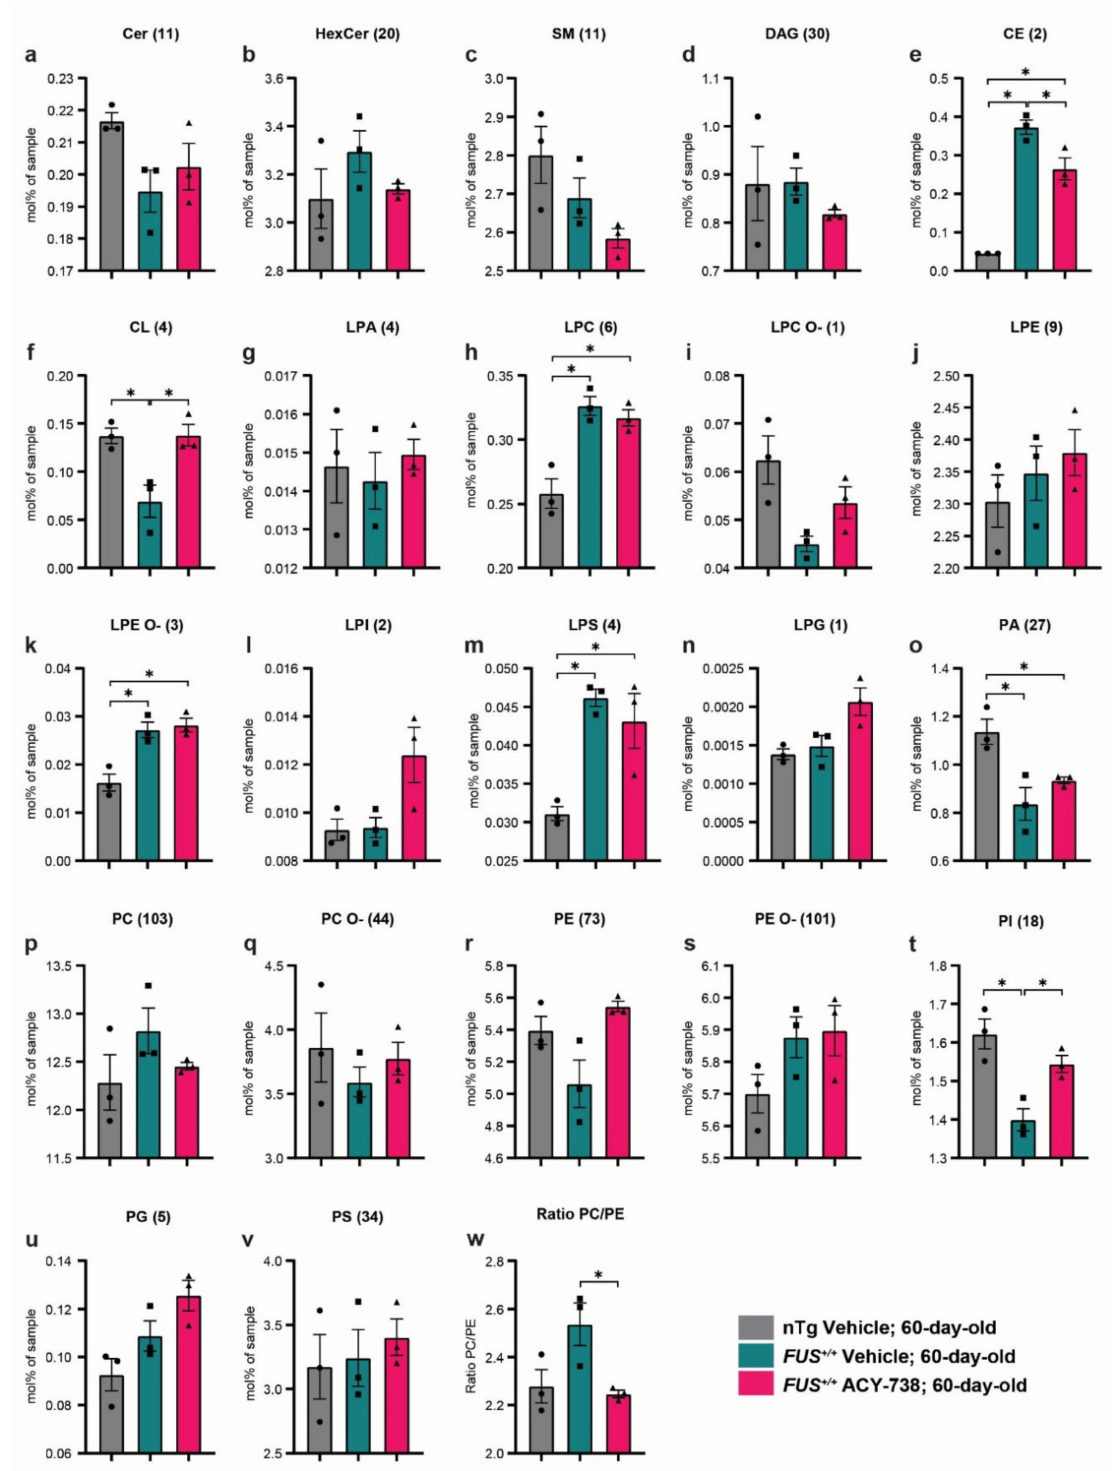
Figure 2. ACY-738 treatment mitigates specific lipid classes defects in 60-day-old mice FUS +/+ mice ( a – v ) Differences in the concentration of all lipid classes analyzed in 60-day-old vehicle-treated nTg controls and vehicle- or ACY-738-treated FUS +/+ mice. Each graph represents a distinct lipid class, and the number of lipids summed per class is indicated within brackets. ( w ) Ratio of the percentage of moles of sample from PC to PE in 60-day-old vehicle-treated nTg controls and vehicle- or ACY-738-treated FUS +/+ mice. Data are in percentage of moles of the sample, presented as mean ± standard error of the mean (SEM). Statistical significance was calculated by 1-way ANOVA, followed by Tukey’s post-hoc test. * p < 0.05, FDR